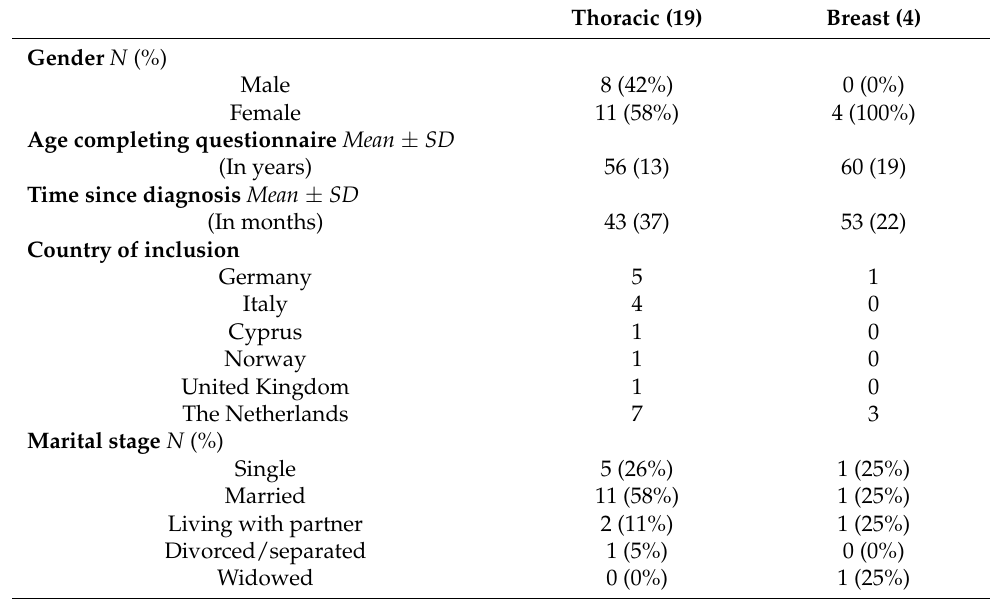
Table 1. Patient